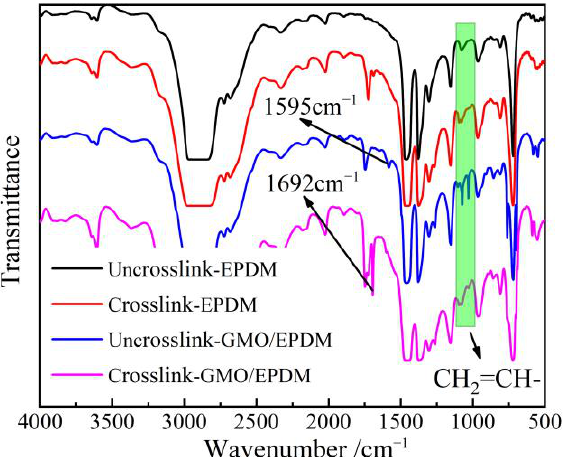
Figure 3. Infrared transmission spectra of EPDM and GMO/EPDM blend before and after crosslink- ing process.